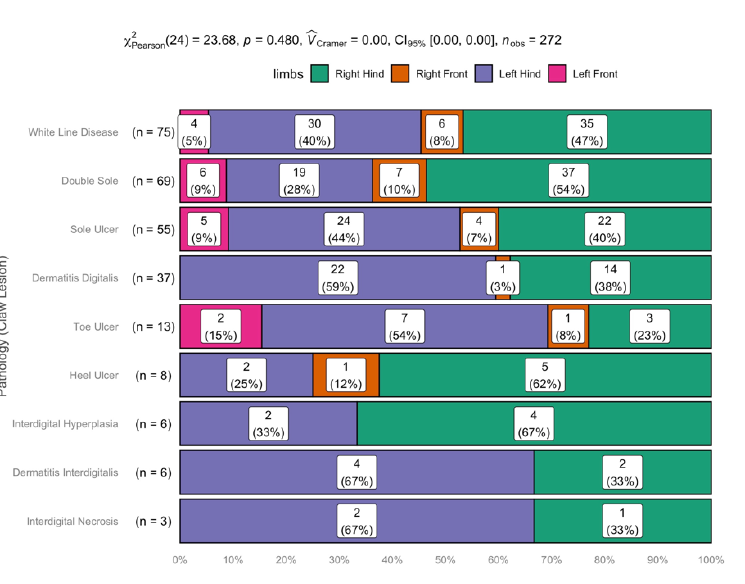
Figure 1. Distribution of occurrence of lameness in the front and hind limbs in animals diagnosed with left displaced abomasum and claw diseases (LDA + CLAW). Occurrence of claw lesions is given as ‘yes’ (blue) and ‘no’ (black). Significant differences of >0.01 are presented as **. Hind limbs were affected significantly more often than front limbs. In 33.3% of animals ( n = 33), claw lesions were found in both hind limbs.